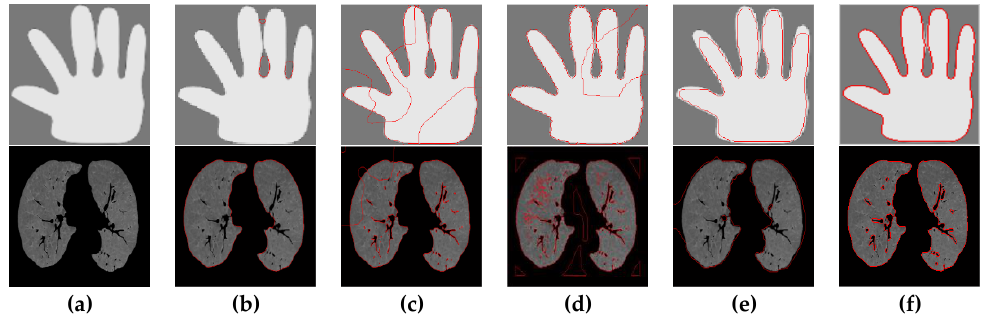
Figure 6. Comparisons of the five models in segmenting simple medical images: (a) The original image; (b) The segmentation results of the DRLSE model; (c) The segmentation results of the LBF model; (d) The segmentation results of the LIF model; (e) The segmentation results of the LSACM model; (f) The segmentation results of the IRLS-IS model.